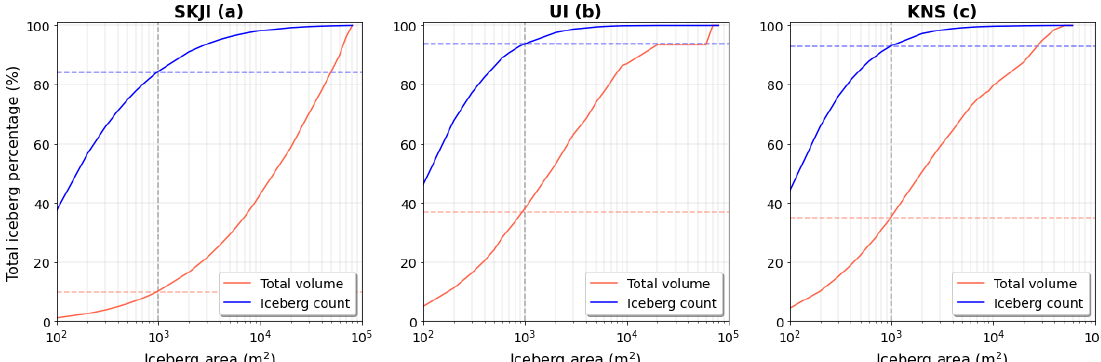
Figure 9. Cumulative iceberg volume (orange line) and count (blue line) plotted as percentage with their respective surface area. The small iceberg threshold ( < 1000m 2 ) is defined by a dashed grey line. The total volume made up by small icebergs is represented by the dashed orange line and the total number is the dashed blue